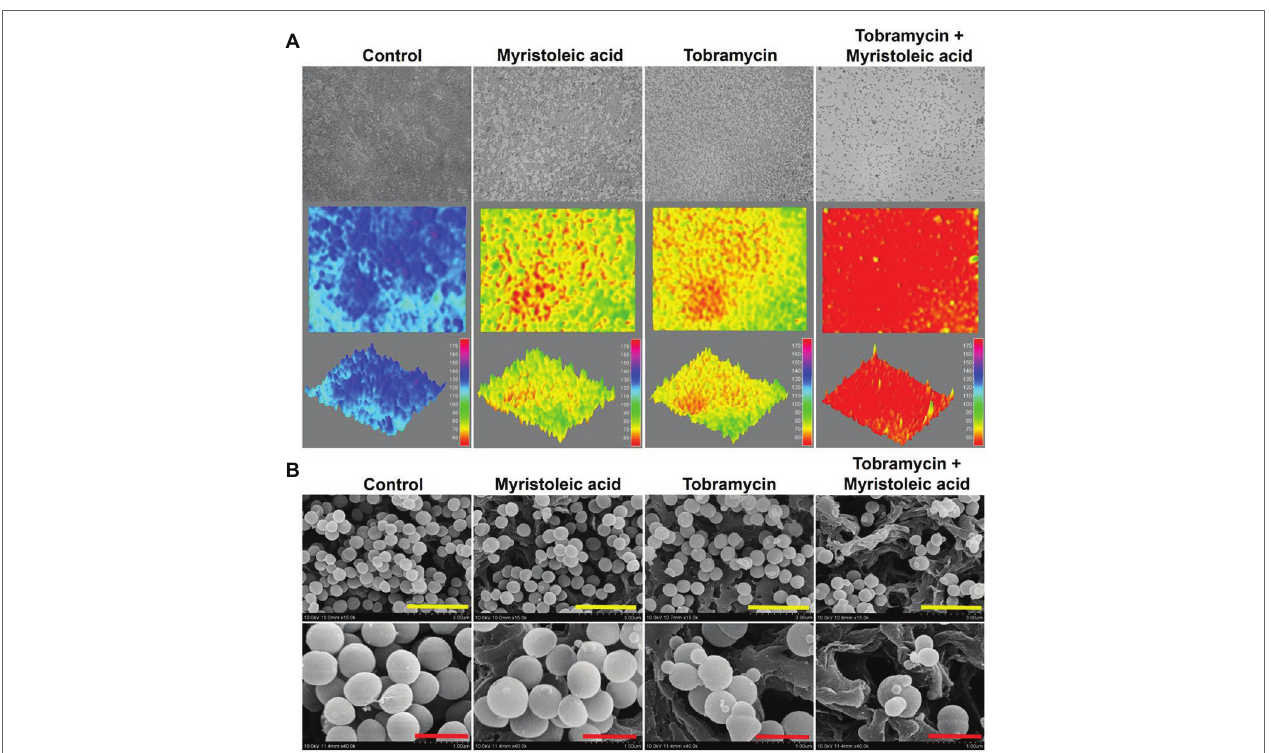
FIGURE 5 | Biofilm cells of Staphylococcus aureus grown in the presence or absence of myristoleic acid and/or tobramycin. Biofilm inhibitions by myristoleic acid (20 μ g/ml) and/or tobramycin (5 μ g/ml) were determined after culture for 24 h under static conditions. Re-created color-coded 2D and 3D images of Staphylococcus aureus biofilms (A) . SEM images of Staphylococcus aureus biofilms formed in the presence or absence of myristoleic acid (20 μ g/ml) and/or tobramycin (5 μ g/ml; B ). Yellow and red scale bars represent 3 and 1 μ m, respectively. Control; untreated